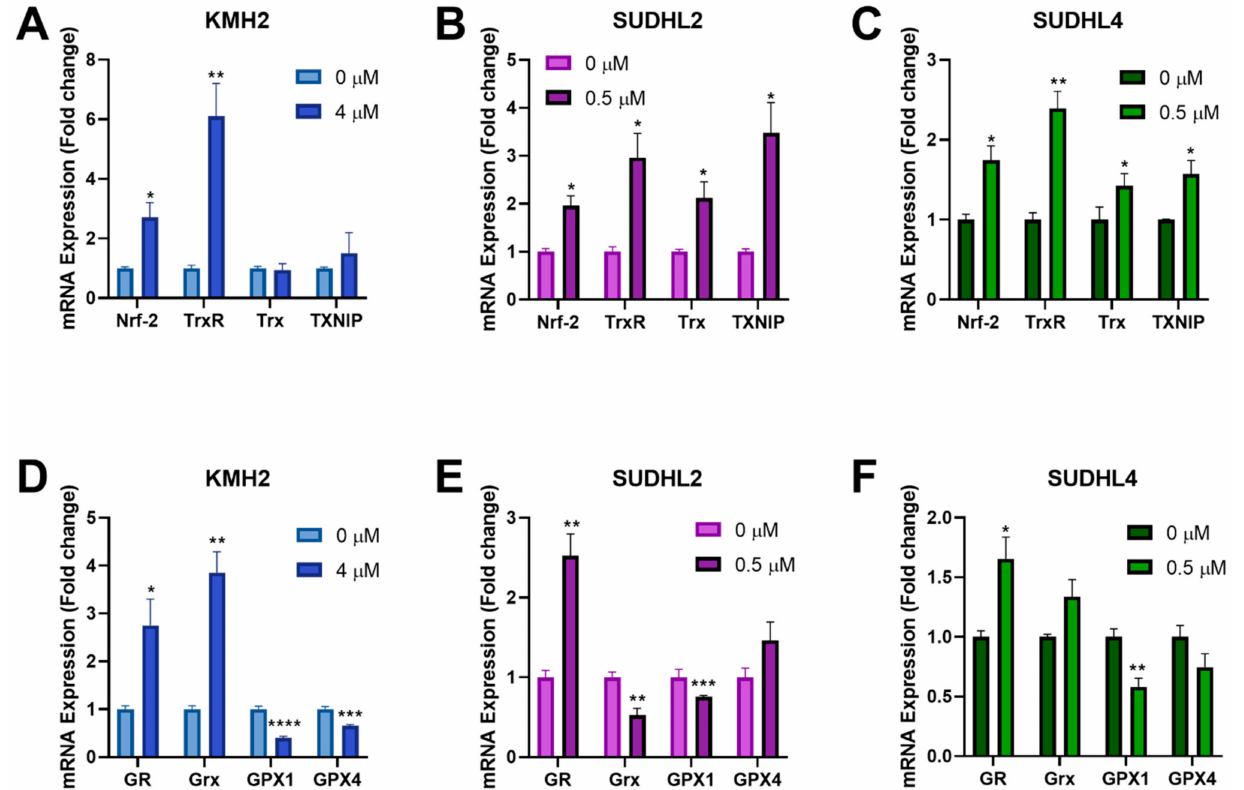
Figure 5. [Au(d2pype)2]Cl modulates the gene expression of antioxidant proteins. ( A , D ) KMH2, ( B , E ) SUDHL2, and ( C , F ) SUDHL4 cells were exposed to the indicated [Au(d2pype)2]Cl for 24 h. mRNA expression levels of Nrf-2, TrxR, Trx, TXNIP, GR, Grx, GPX1, and GPX4 were measured using RT-qPCR. Results were analysed by via two-way ANOVAs with Dunnett’s post hoc test. Values indicate mean ± SEM ( n = 3). * p < 0.05, ** p < 0.01, *** p < 0.001, **** p <